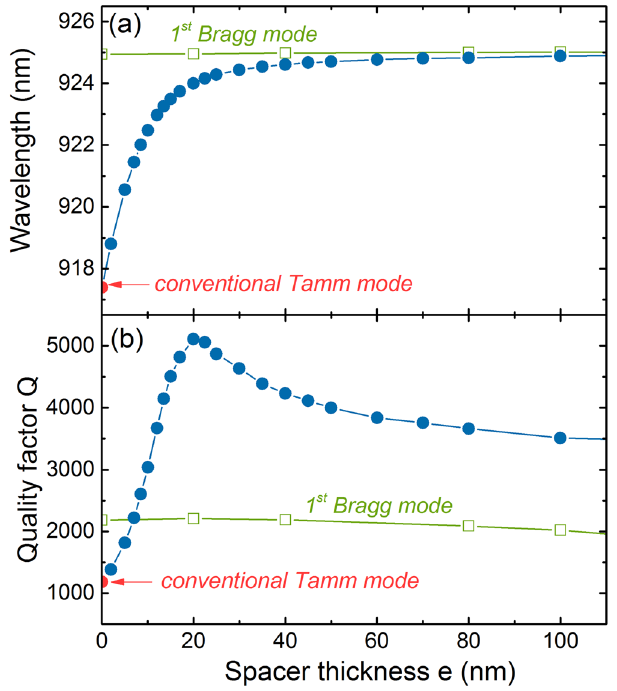
Figure 2. Variation of ( a ) resonance wavelength and ( b ) quality factor with the spacer thickness calculated by the transfer matrix method. The spacer (n = 1.485) is either inserted between a 65 pairs DBR and a 45 nm thick silver layer (blue circles) or deposited on a 65 pairs DBR without metal (green open